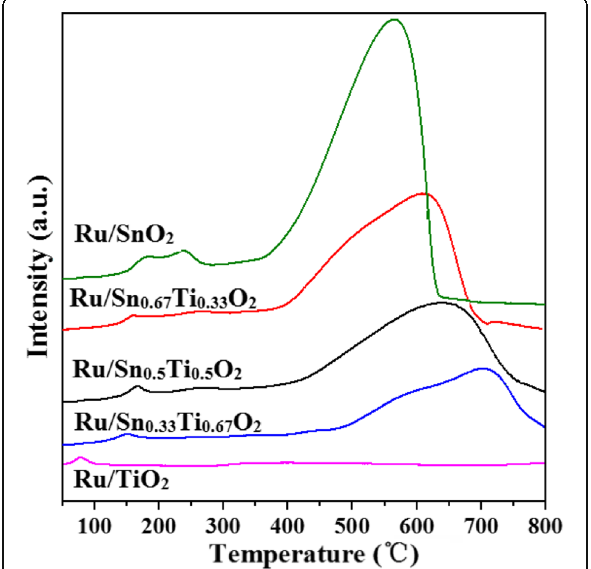
Fig. 10 O 2 -TPD spectra of Ru/TiO 2 ( a ), Ru/Sn 0.33 Ti 0.67 O 2 ( b ), Ru/ Sn 0.5 Ti 0.5 O 2 ( c ), Ru/Sn 0.67 Ti 0.33 O 2 ( d ), and Ru/SnO 2 catalysis